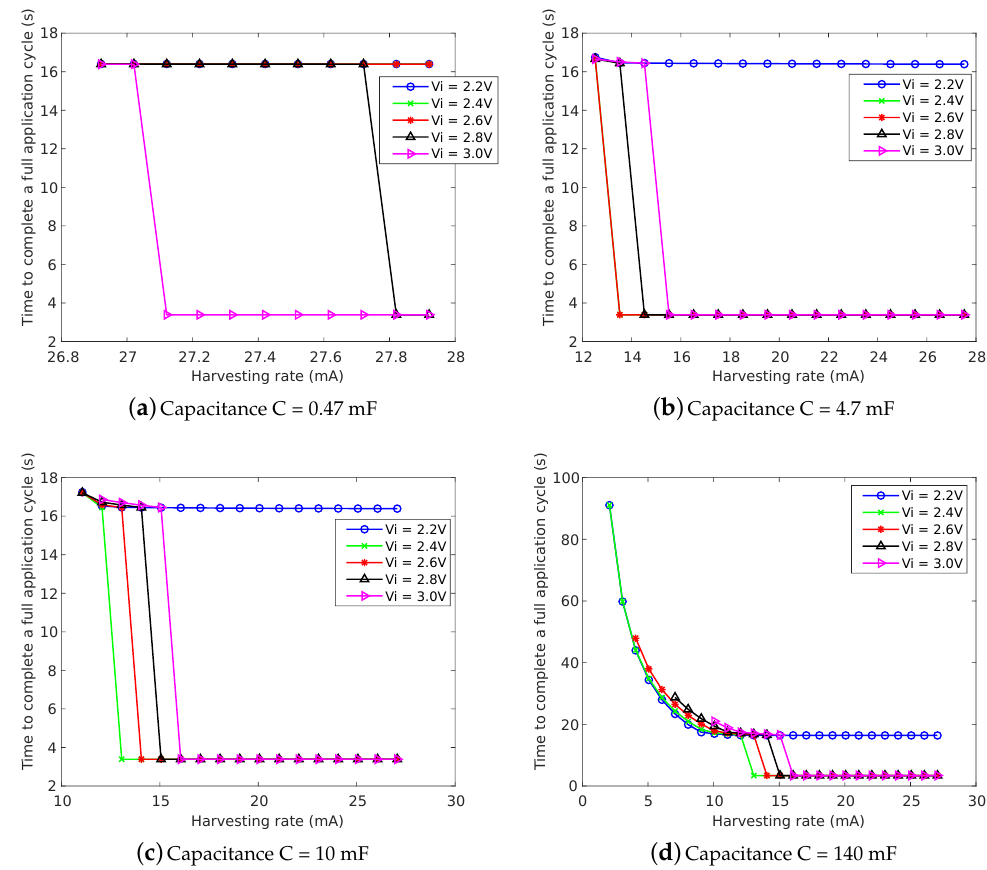
Figure 10. Full cycle time for different voltages and harvesting rates considering different capacitor sizes, for the TurnOff